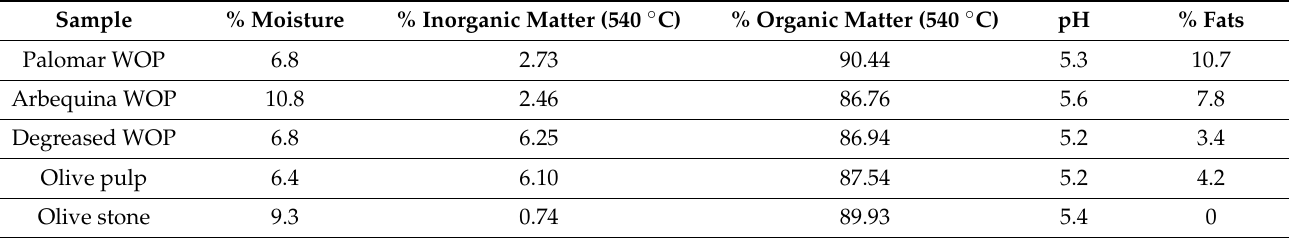
Table 2. Chemical characterization of the five fractions of